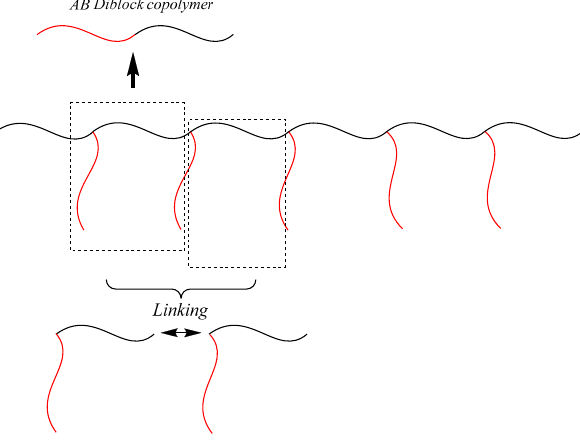
Figure 4. Synthesis of (EDGP) by the linking reaction between two AB diblock copolymers. Polymers 2017 , 9 , 470 14 of Table 6. Characterization results of exactly defined (PMMA– graft –PSt)s synthesized by the iterative methodology.